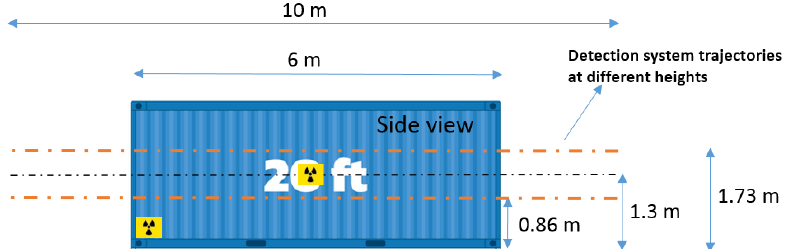
Figure 10. Mobile radiation detection system trajectories performed during the lateral wall inspections of the shipping container